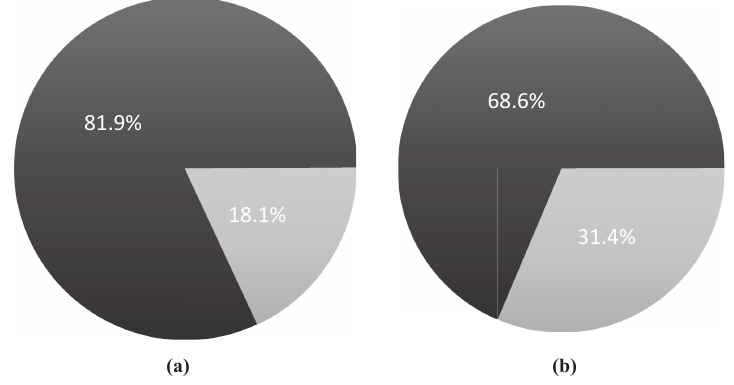
Figure 3. (a) Proportion of Thai people aged 60 or over in 2020, (b)